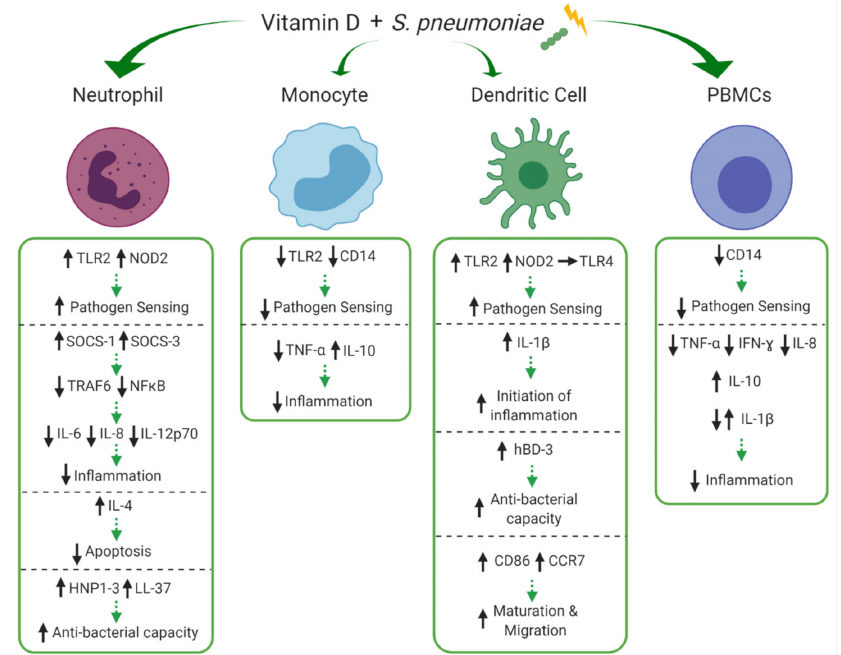
Figure 3. Effects of vitamin D on innate cell subsets in response to Streptococcus pneumoniae ( S. pneu- moniae) . Vitamin D differentially modulates expression of pathogen recognition receptors, toll-like receptor 2 (TLR2), TLR4, CD14 and nucleotide-binding oligomerization domain-containing protein 2 (NOD2) on neutrophils, monocytes, dendritic cells (DCs) and peripheral blood mononuclear cells (PBMCs) altering their pathogen sensing capacity. Vitamin D increases production of IL-4 in neu- trophils, decreasing apoptosis, whilst also increasing production of suppressor of cytokine signalling 1 (SOCS-1) and SOCS-3, reducing tumour necrosis factor receptor-associated factor 6 (TRAF6) and nuclear factor kappa B (NF κ B), overall reducing excessive inflammation (IL-6, IL-8, IL-12p70). Vita- min D modulates TNF- α , IFN- G , IL-8 and IL-10 in monocytes and PBMCs and IL-1 β is differentially modulated in PBMCs and DCs, potentially contributing to initiation of the inflammatory process (IL-1 β ), but overall reducing excessive inflammation. Production of human beta-defensin 3 (hBD-3) within DCs and human neutrophil peptide (HNP1-3) and LL-37 within neutrophils is enhanced by treatment with vitamin D, potentially increasing anti-bacterial capacity. Finally, the maturation and migration (CD86 and C-C chemokine receptor type 7 (CCR7)) of DCs is upregulated by vitamin D, priming these cells for interactions with adaptive immunity. ↑ / ↓ indicates increase or decrease and → indicates no difference/change to response during immune stimulation with versus without the experimental addition of vitamin D. Green arrows indicate potential net effect. (Created with BioRender.com